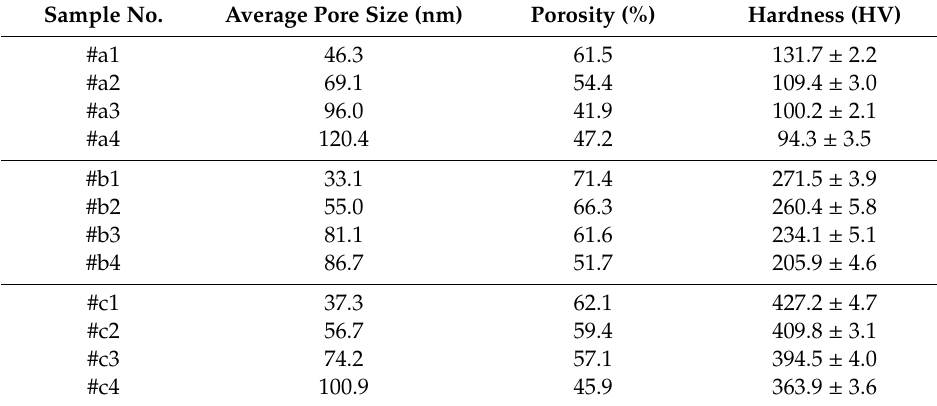
Figure 2. Aluminum oxide film obtained via the anodizing process in the electrolyte of ( a ) phosphoric acid with a concentration of 15 wt% under a constant voltage of 40 V ( a1 ), 50 V ( a2 ), 60 V ( a3 ), and 70 V ( a4 ); ( b ) sulfuric acid with a concentration of 11 wt% under a constant voltage of 20 V ( b1 ), 25 V ( b2 ), 30 V ( b3 ), and 35 V ( b4 ); ( c ) oxalic acid with a concentration of 5 wt% under a constant voltage of 40 V ( c1 ), 45 V ( c2 ), 50 V ( c3 ), and 55 V ( c4 ). Table 2. Average pore size, porosity, and Vickers’ hardness of the samples (sample no. as same as that in Figure 2). Sample